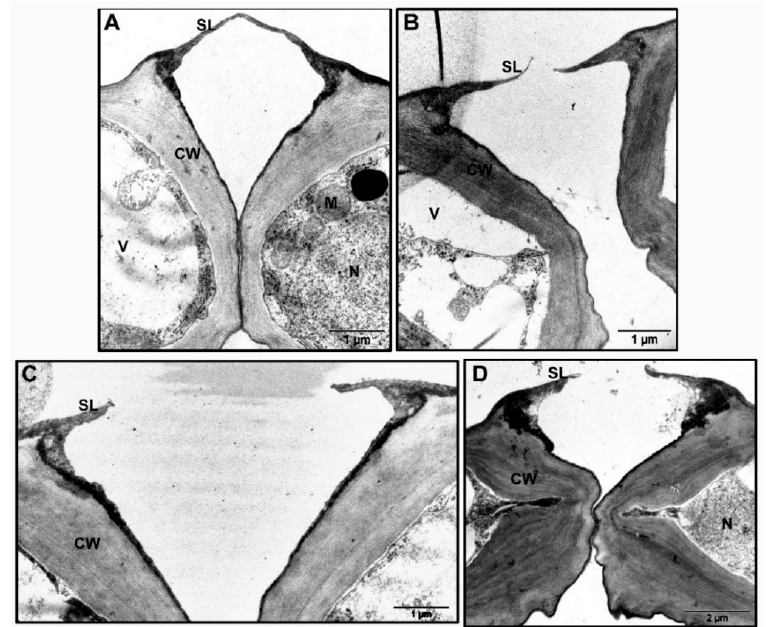
Figure 8. TEM of stomata complex and GCs (transdermal sections; adaxial side) from rosette leaves of WT, tgg1 , tgg2 single, and tgg1 tgg2 double mutants of Arabidopsis revealed variations for outer stomatal ledge and cell wall. ( A ). WT: Stomata complex showing nucleus, mitochondria, and vacuole in either of the GC. Cell wall is differentially thickened with thickest near the stomatal pore, and thin between the GCs. The stomatal ledge is attached at the end of stomatal pore. ( B ). tgg1 single mutant: Stomata complex showing vacuolated GC, with thick cell wall near the stomatal pore. GCs showing stomatal ledges at the end of stomatal pore. ( C ). tgg2 single mutant: Stomata complex showing thick cell wall and reduced stomatal ledges at the end of stomatal pore. ( D ). tgg1 tgg2 double mutant: Stomata complex showing very thick cell wall between the GCs and very thick stomatal ledges. CW = cell wall, M = mitochondria, N = nucleus, SL = stomatal ledge, and V = vacuole (Bars in A – C = 1 µm and in D =2 µm), (Magnification = 18,500× in A – C ; and 11,000× in D ).